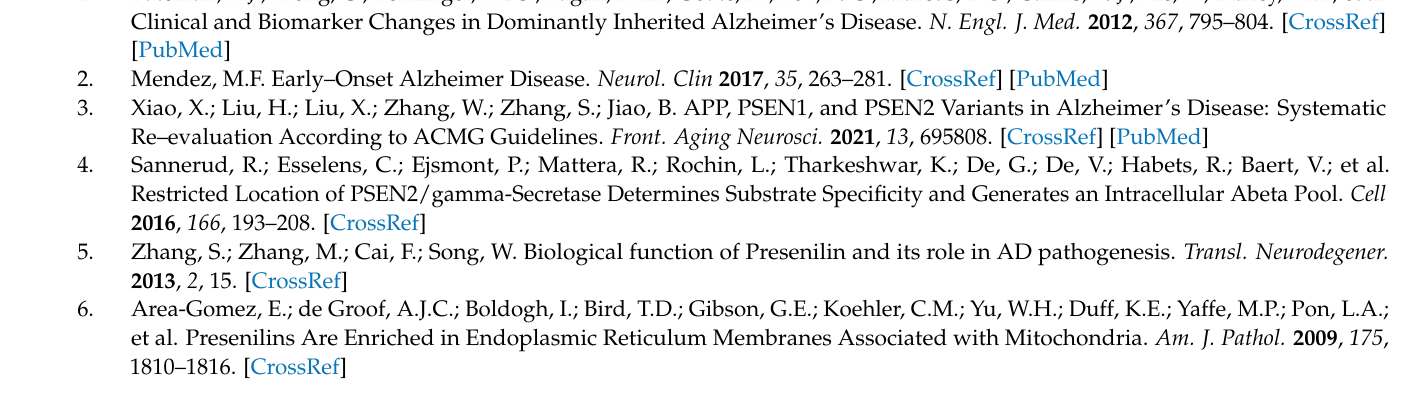
and heart development; Figure S2: Effect of Psen2 absence on muscle development; Figure S3: Effect of human AD–linked PS2–T122R expression on mitochondrial axonal transport in psen2 − / − embryos; Figure S4: Effect of Psen2 genetic manipulation on mitochondrial density; Figure S5: Effect of Psen2 genetic manipulation on mitochondrial